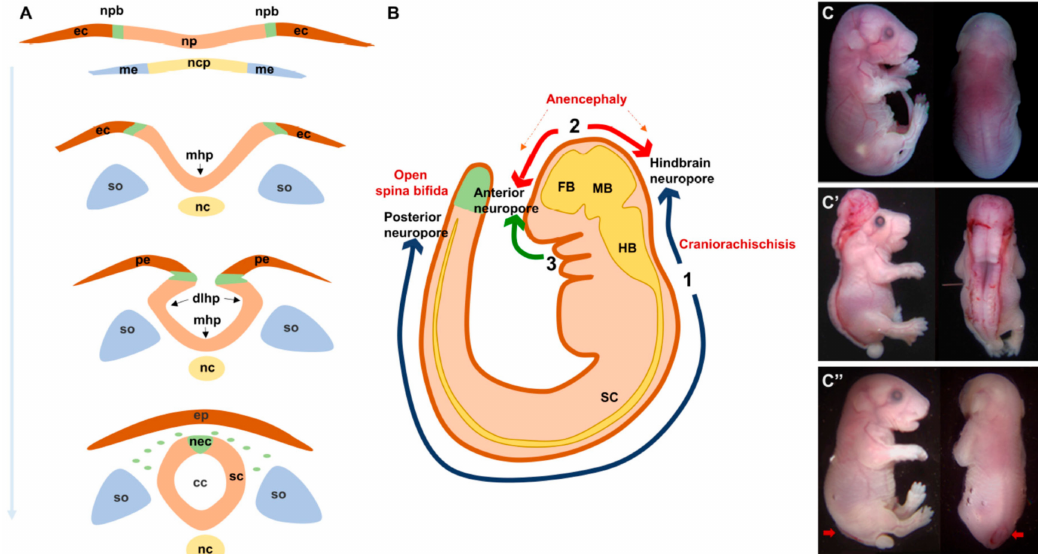
Figure 1. Normal and abnormal neural tube formation. ( A ) Major steps of neural tube formation. The neural plate overlying the notochord elevates to form the neural folds around the midline, bends at the midline (mhp) and dorsolateral sites (dlhp) then fuses at the opposing tips of the neural folds and separates from the overlying epidermis. ( B ). Initiation sites of neural tube closure 1–3 in a mouse embryo. Defects in closure 1 and 2 lead to craniorachischisis and anencephaly respectively. Defects in closure at the caudal end of site 1 lead to open spina bifida. ( C ). Lateral and dorsal views of E18.5 embryos showing craniorachischisis ( C (cid:48) ) and open spina bifida ( C” , indicated by red arrows) as compared to wild type ( C ). cc, central canal; dlhp, dorsolateral hinge point; ec, ectoderm; ep, epidermis; fb, forebrain; hb, hindbrain; mb, midbrain; mhp, median hinge point; me, mesoderm; nc, notochord; ncp, notochordal plate; nec, neural crest; np, neural plate; npb, neural plate border; pe, presumptive epidermis; sc, spinal cord; so,